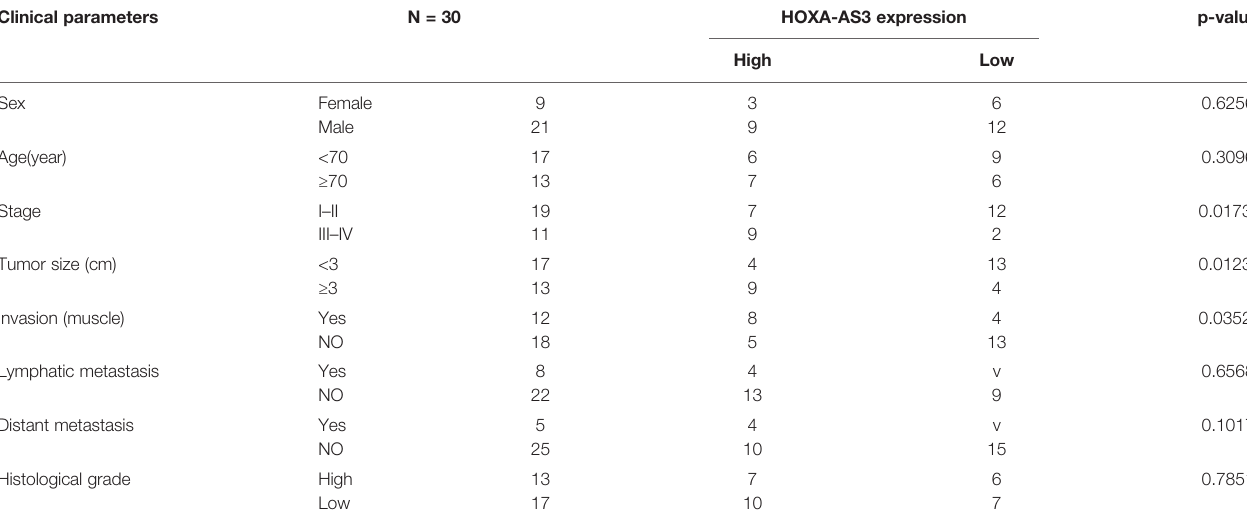
TABLE 2 | The correlations between HOXA-AS3 and clinical characteristics of bladder cancer patients. Clinical